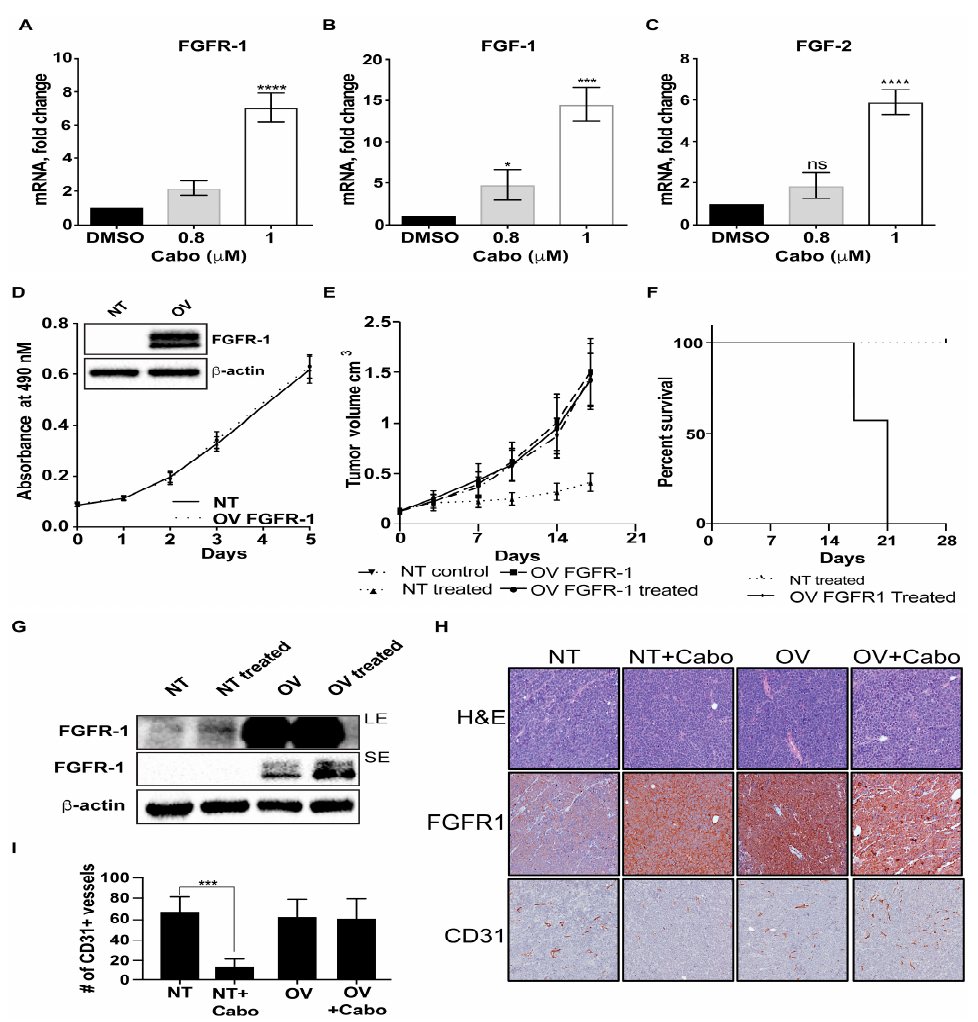
Figure 1. FGFR1 overexpression mediates acquired resistance to MET/VEGFR2 inhibition. ( A – C ) Cabozantinib (Cabo) induces the transcriptional upregulation of FGFR1, FGF1, and FGF2. MDA PCa 144-13 cells were treated continuously with the indicated doses of cabozantinib in vitro. Relative FGFR1, FGF1, and FGF2 mRNA expression was analyzed by qRT-PCR. GAPDH was used as a control. Results are expressed as fold change compared to vehicle-treated cells. Columns represent mean values ± SEM. ( D ) Overexpression of FGFR1 in MDA PCa 144-13 cells. Western blotting for FGFR1 expression. Whole-cell extracts obtained from MDA PCa 144-13 cells transfected with a nontargeting (NT) vector or an overexpressing (OV) FGFR1 vector were analyzed. ( E ) Growth of NT and OV FGFR1 cells in vivo. Mice were treated by oral gavage with 30 mg/kg cabozantinib or H 2 O for indicated times. ( F ) Modified Kaplan-Meier curve of mice with OV FGFR1 and NT tumors treated with cabozantinib. Statistical analysis by log-rank (Mantel–Cox) test for time to 1500 mm 3 tumor volume. ( G ) Immunoblot analysis for FGFR1 expression of MDA PCa 144-13 tumor lysates from NT, NT cabozantinib-treated, OV, and OV cabozantinib-treated tumors. LE, long exposure. SE, short exposure. (H , I) Effect of cabozantinib treatment on vasculature. H&E staining and immunohistochemistry of FGFR1 and CD31 expression in NT and OV MDA PCa 144-13 tumors in the presence and absence of cabozantinib are compared. * p < 0.05; *** p < 0.01; **** p < 0.001. More details of western blot, please view at the supplementary